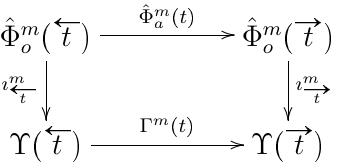
Figure 3. The construction of injection for a relational product (note that ˆ Φ m